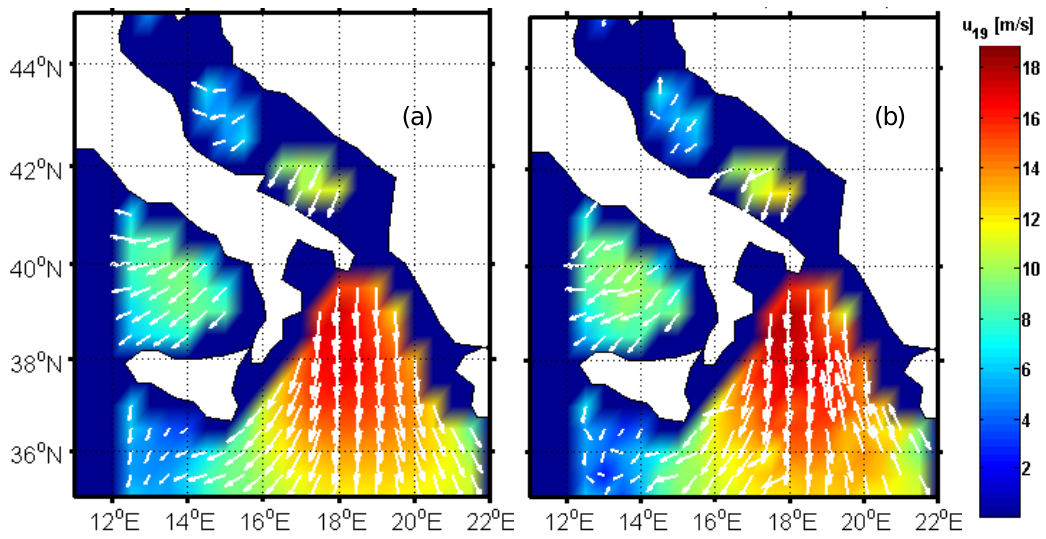
Figure 8 . ECMWF (a) and estimated (b) wind fields for the analyzed case study. White arrows denote direction where wind is blowing. Their length is proportional to wind speed.